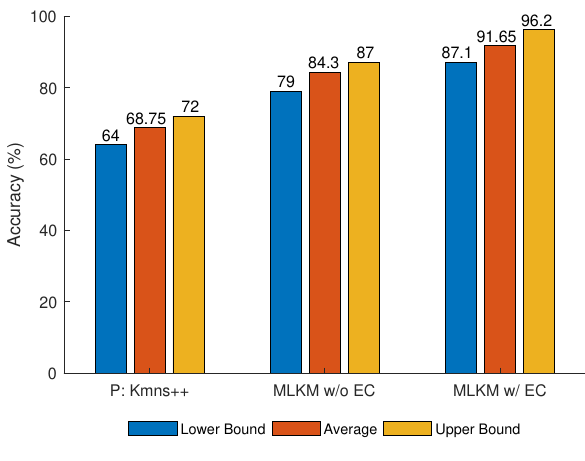
Figure 8. K-means++ for preprocessed data (P:K-means++), multi-layer k-means++ (MLKM) without error correction (MLKM w/o EC) and MLKM with error correction (MLKM w/